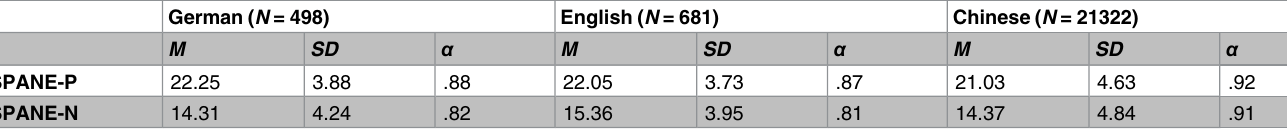
Table 2. Means, standard deviations, and internal consistencies of SPANE versions.